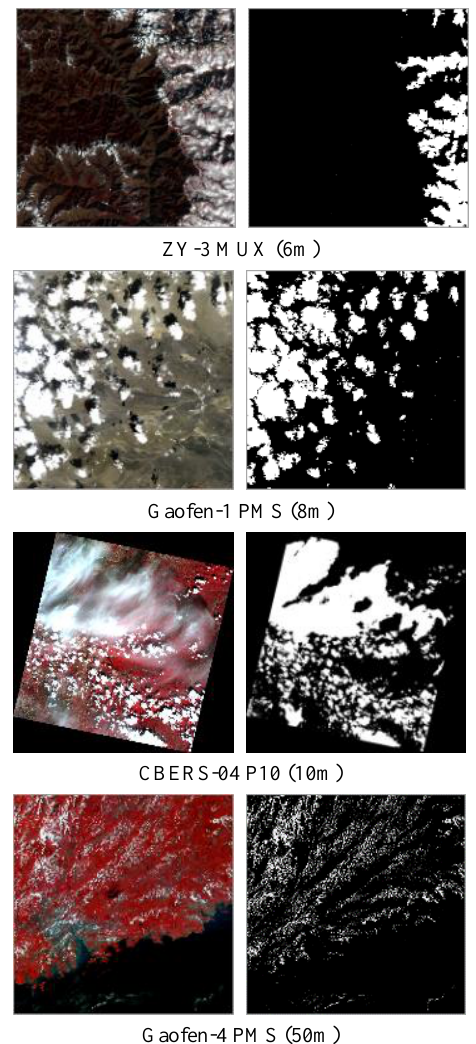
Figure 6. Cloud detection examples of MSCN in other kinds of multispectral imagery in different land